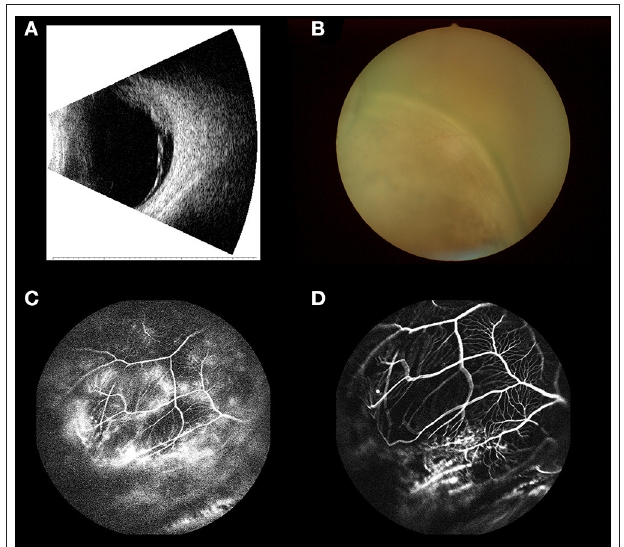
FIGURE 2 | Ophthalmic imaging (ocular B-ultrasound, fundus photography, ICGA FFA) in patients with lung cancer ocular metastasis. (A) Ocular B-ultrasound. (B) Fundus photography. (C) ICGA. (D) FFA. ICGA, indocyanine green angiography; FFA, fundus fluorescein angiography.